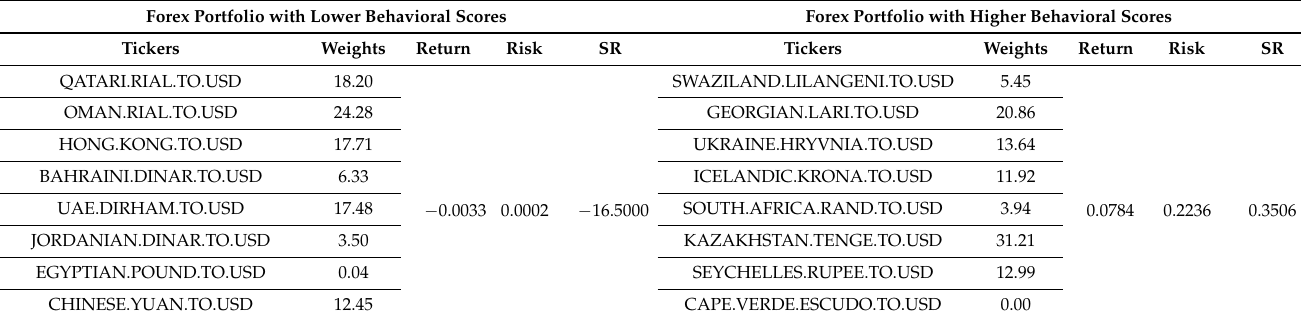
Table 8. Optimization results of Forex portfolios using the BMV